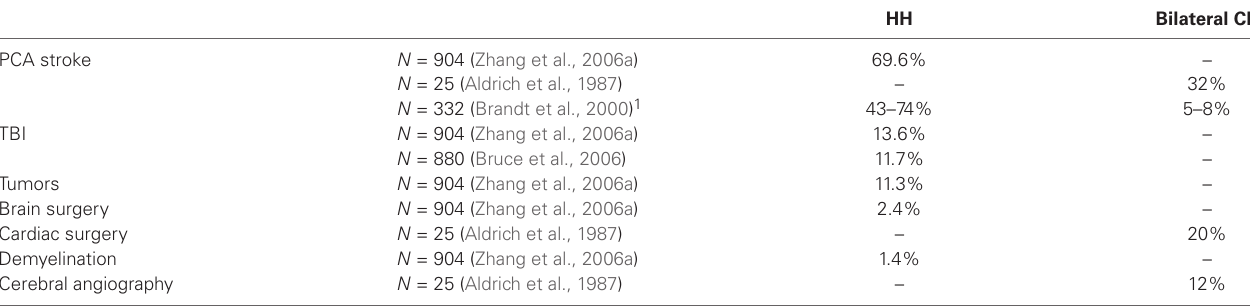
Table 1 | Etiologies of HH and bilateral cortical blindness (bilateral CB) reported in the literature